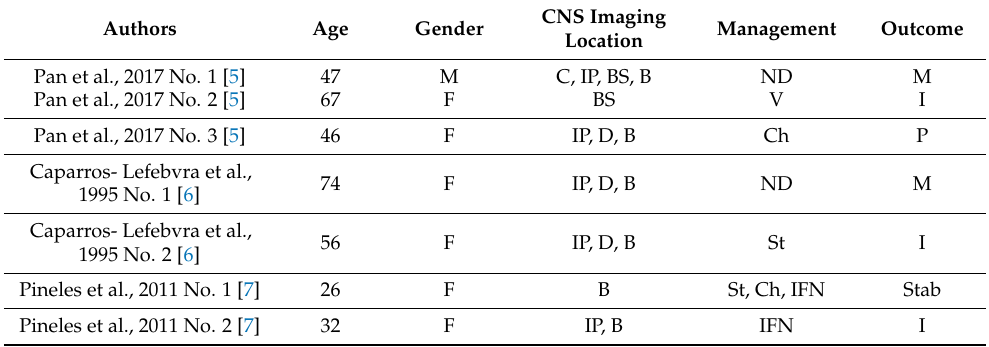
Table 3. Demographic data and CNS lesion location, management, and outcome of cases used for this systematic